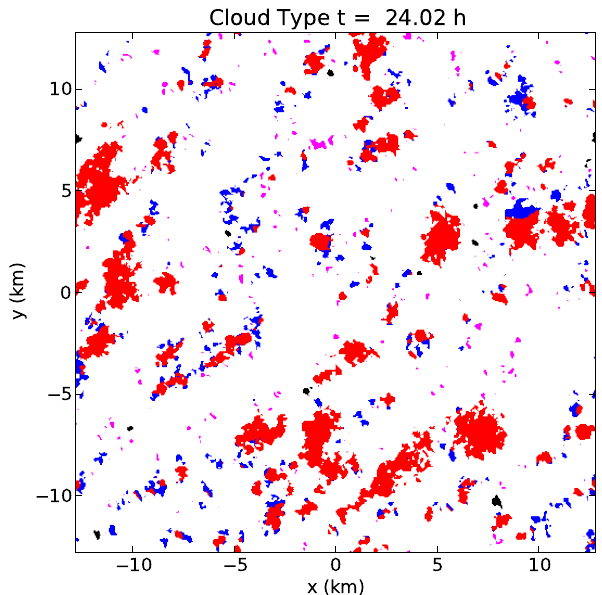
Fig. 5. The same projection of the cloud field as Fig. 4, but with the color depicting the type of cloud: magenta clouds are passive, black clouds are single pulse clouds, and blue clouds are remnants of the red active multicell clouds.